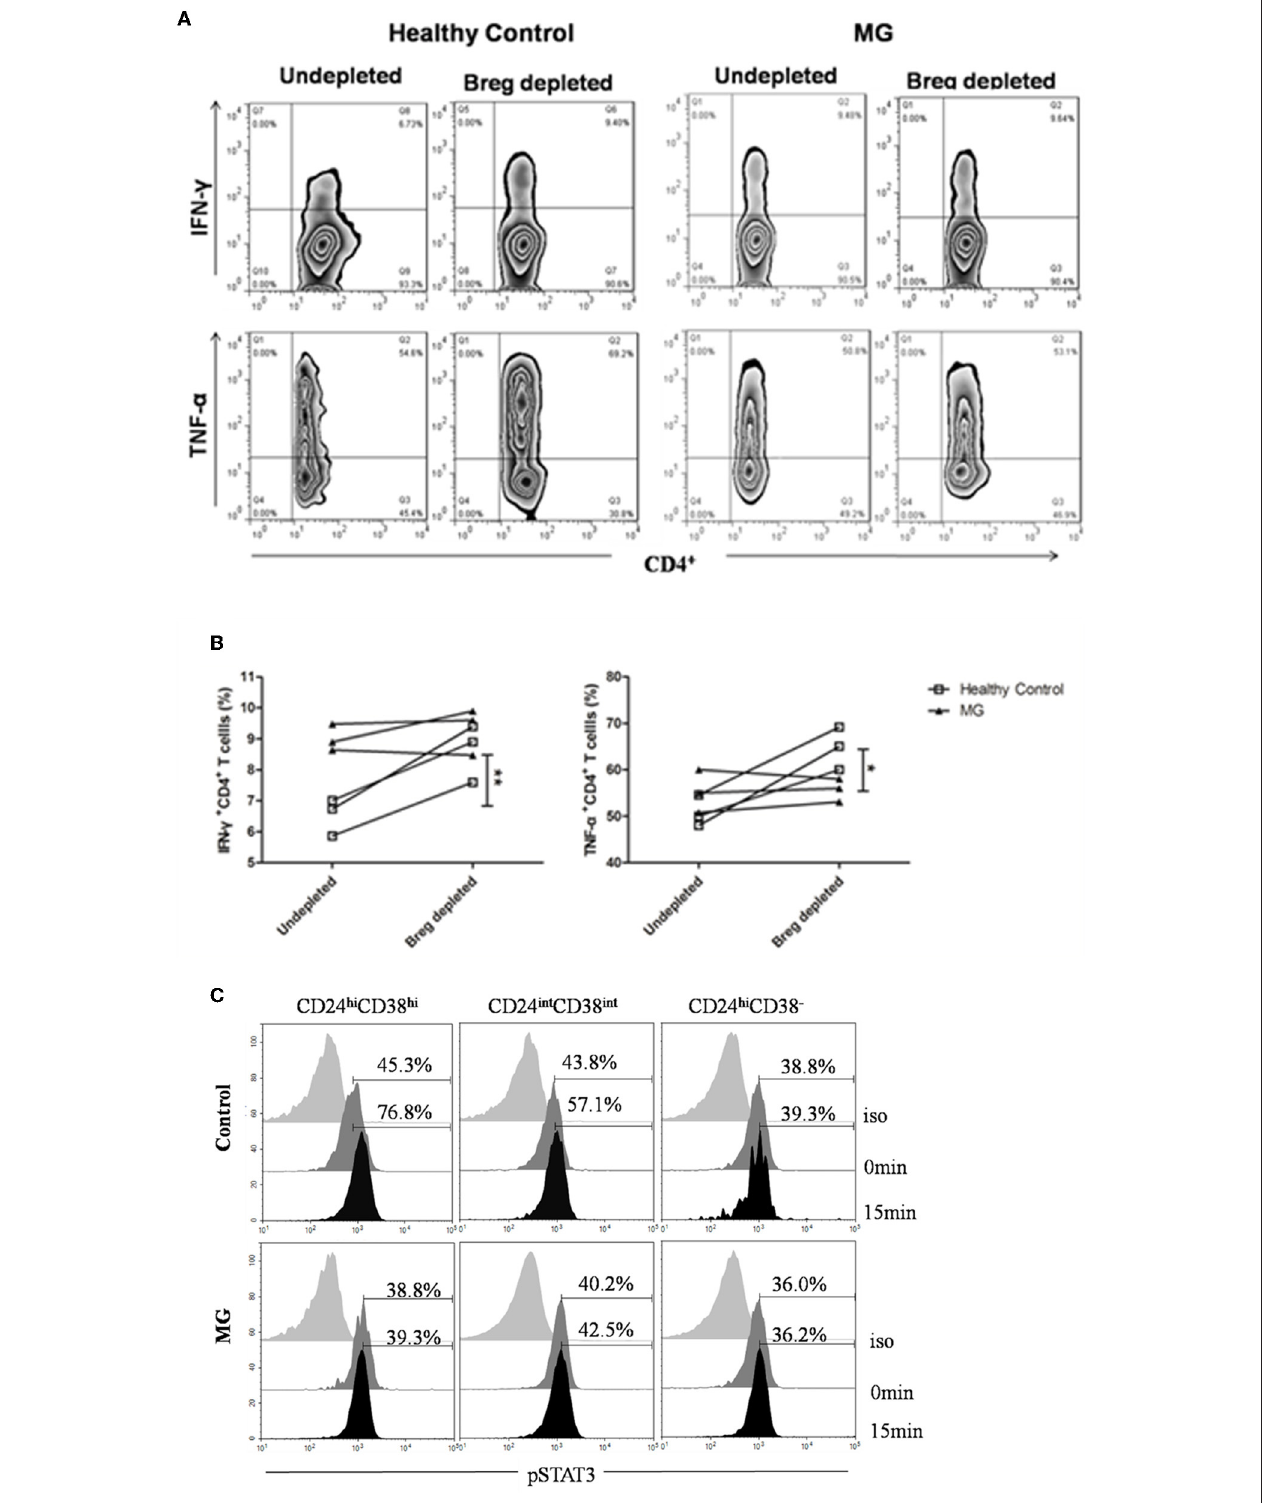
FIGURE 5 | CD19 + CD24 hi CD38 hi B cells from MG patients fail to suppress IFN- γ + and TNF- α + CD4 + T cell differentiation. B cells isolated from patients with MG or healthy controls were stained with CD19, CD24, and CD38 and gated, as shown in Figure 2A . CD19 + CD38 hi CD24 hi B cells were depleted, and the depleted B cells and undepleted B cells were both collected using flow cytometry sorting. CD4 + T cells were collected by magnetic-bead purification, and then, B cells and CD4 + T